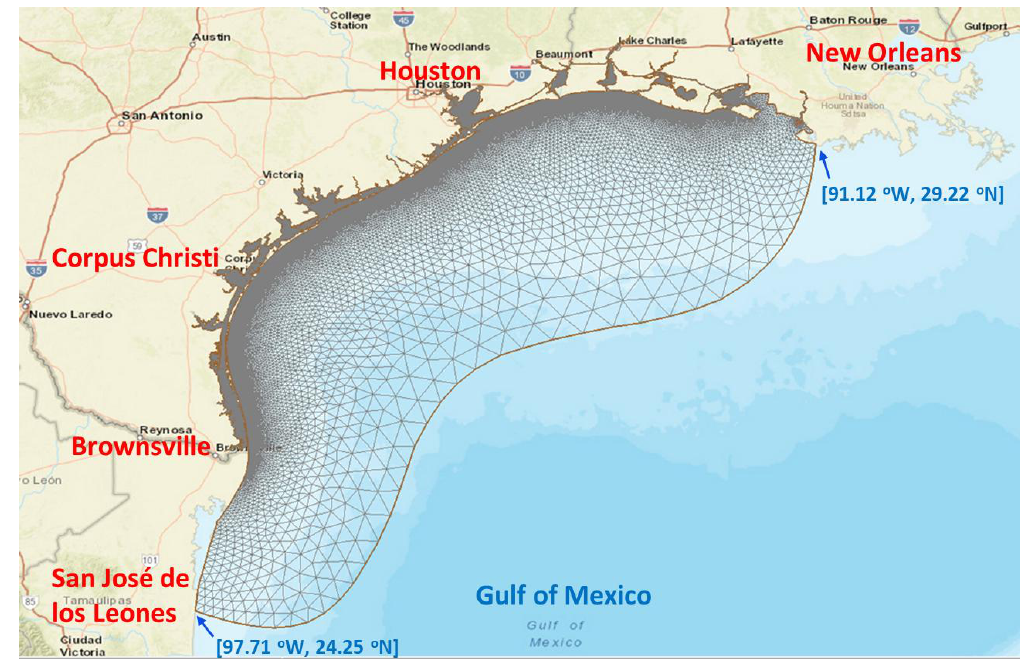
Figure 1. Model domain for the TX and western LA coastal regions.